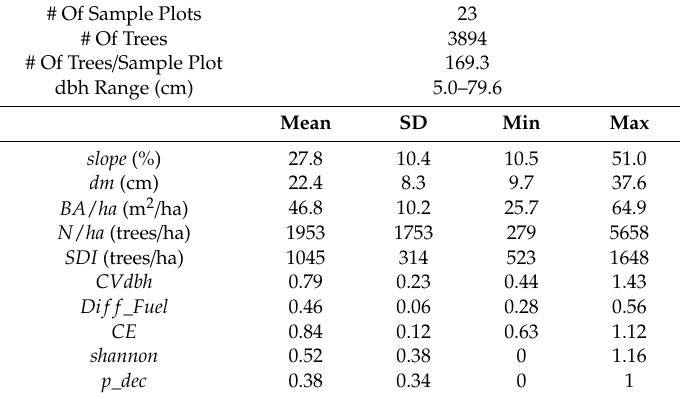
Table 1. Summary statistics of sample plots. slope , slope of sample plot; dm , diameter of mean basal area tree; BA / ha , basal area per hectare; N / ha , number of trees per hectare; SDI , stand density index; CVdbh , coe ffi cient of variation of diameter at breast height; Dif f _ Fuel , dbh di ff erentiation according to Füldner; CE , Clark and Evans aggregation index; shannon , Shannon index; p _ dec , proportion of deciduous trees. # Of Sample Plots 23 # Of Trees 3894 # Of Trees / Sample Plot 169.3 dbh Range